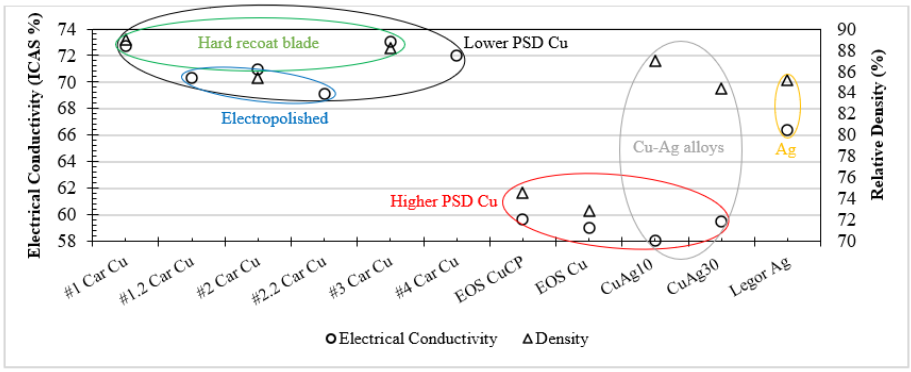
Figure 13. Summary of electrical performance and relative density results for all material composi- tions and process variables considered. Overall, Carpenter Additive Cu consistently outperformed all other Cu variants, Cu –